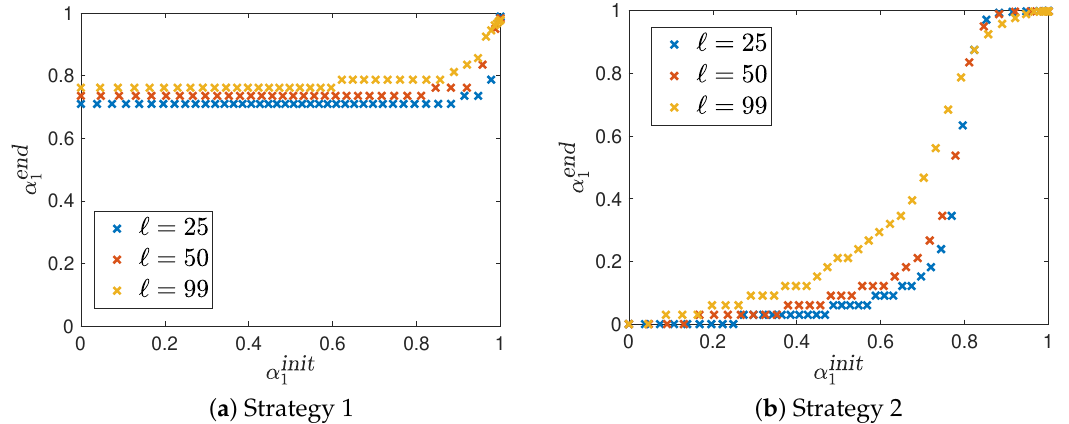
Figure 2. The mapping α init